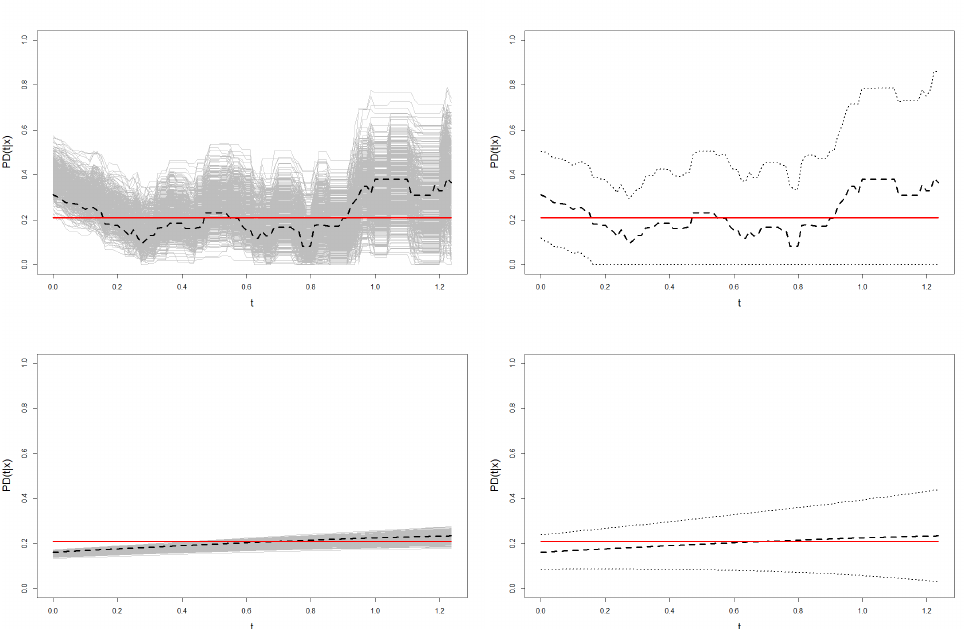
Figure 10. Theoretical PD ( t | x ) (red solid line) and estimation with MISE bandwidths (black dashed line) along with the bootstrap estimations of PD ( t | x ) from B = 500 resamples (gray dashed lines) in the left panel and 95% confidence region (black dotted lines) in the right panel by means of Beran’s estimator ( top ) and the smoothed Beran’s estimator ( bottom ) for one sample from Model 2 when P ( δ = 0 | x ) =